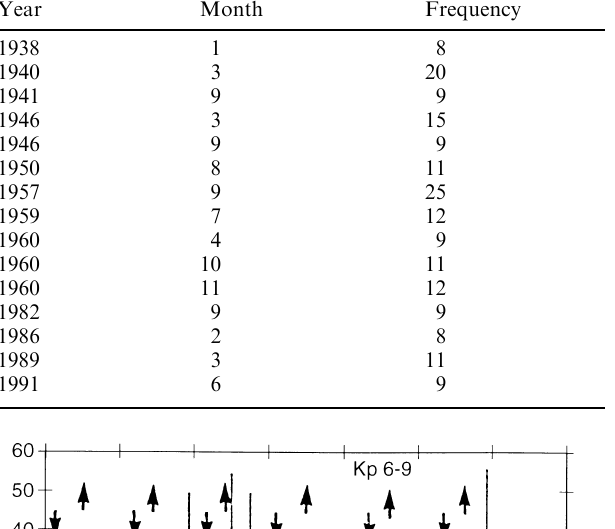
Table 5. Occurrence of Kp (cid:21) 8 (for at least 8 intervals in a month) in the period 1932–1995 Year